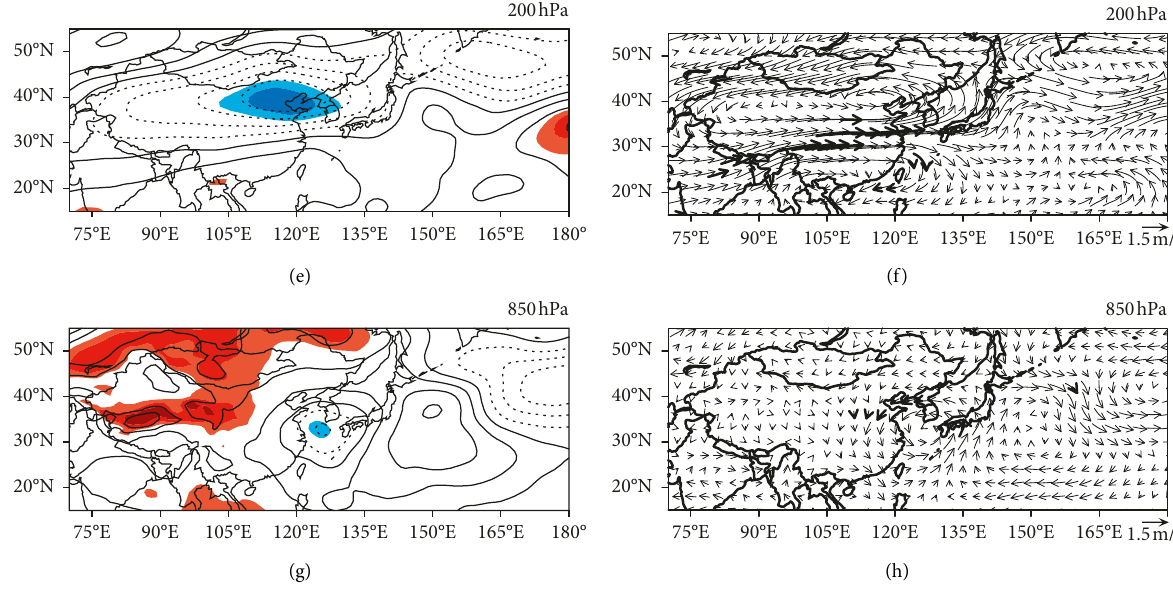
Figure 8: PC2-regressed SSTs in the previous autumn (a), previous winter (b), spring (c), and summer (d) during 2000–2016 (contour interval: 0.1). Previous autumn and winter denote the seasons before one year, which means the PC2-regressed SSTs in autumn and winter between during 1999–2015, respectively. PC2-regressed geopotential height and horizontal winds in boreal summer during 2000–2016 at 200hPa (e, f) and 850 hPa (g, h). Solid (dashed) contours denote positive (negative) anomalies, and thick solid lines denote zero. Red (blue) color shadings from light to dark indicate statistical significance at the 90%, 95%, and 99% levels. Contour intervals are 5 gpdm in (e) and 2 gpdm in (c). Thick vectors in (f) and (h) denote statistical significance at the 95% confidence